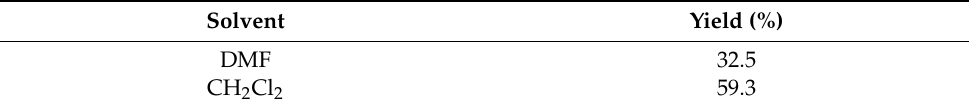
Table 1. Solvent effect of yield compound 2b